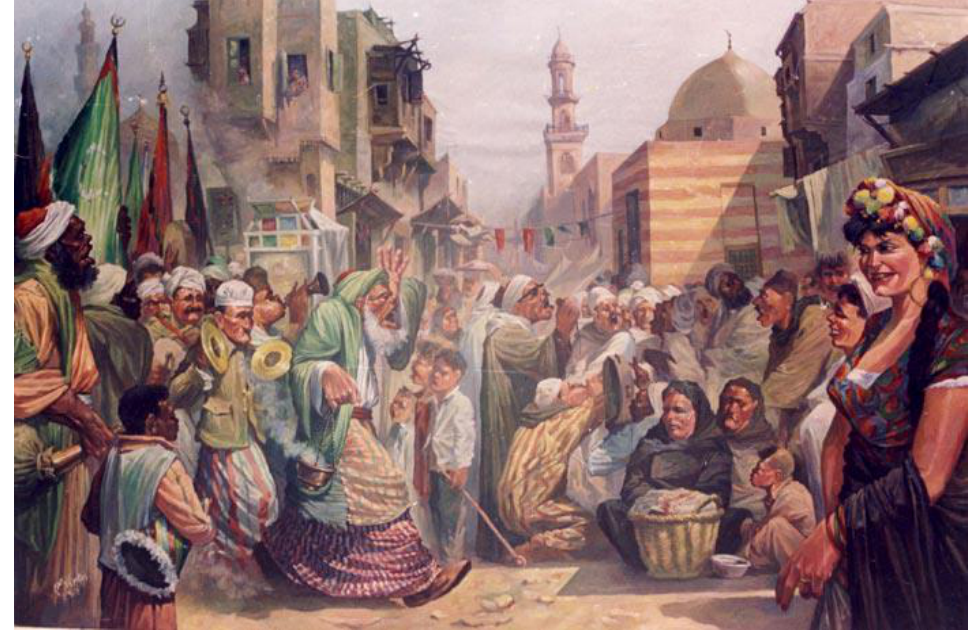
Figure (6) The artist in this work can show the Egyptian identity through the use of architectural symbols that represent a mental map of the city to be a key sign and thus reflect the personality of the